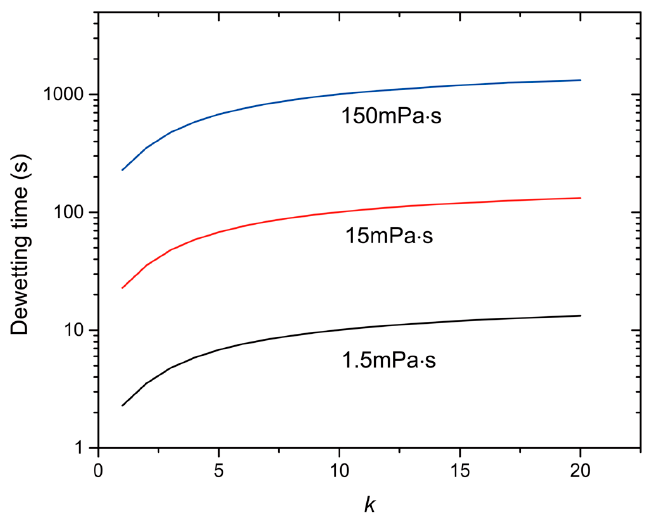
Figure 5. Dewetting time of double emulsion for the poly(2-phenylpropylme-thylsiloxane)/poly(3,3,3-trifluoropropylmethylsiloxane)/water (PPPMS/PFPMS/water) system under different viscosities of the outer phase.